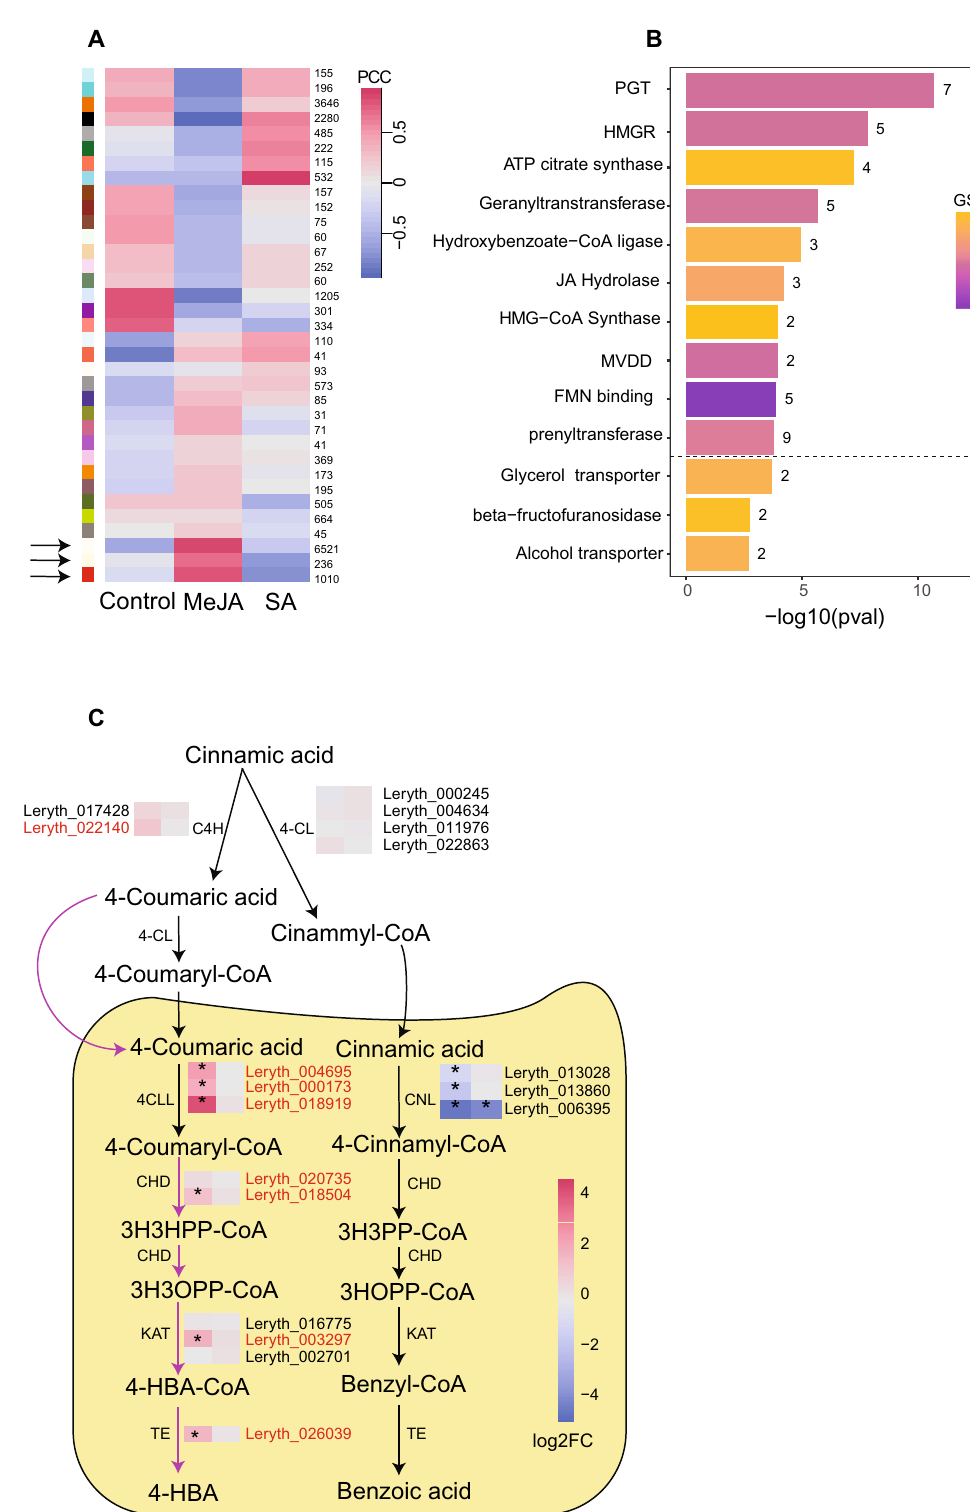
Figure 6. Weighted gene coexpression analysis in Lithospermum officinale . ( A ) Pearson correlation (PCC) of identified modules with each treatment. Each row of the heatmap depicts a single module of clustered genes with dark red and blue colours depicting strong positive and negative correlations, respectively. Numbers on the right represent the total number of genes coexpressed together in the respective module and each colour on the left represents an individual cluster of genes identified by WGCNA. ( B ) GO enrichment analysis of molecular functions of genes coexpressed with LePGT1 in the red subnetwork (n = 243) and LeSAT1 in the light-yellow module (n = 49) after filtering for gene significance (GS > 0.7) and module membership (> 0.7). The heatmap corresponds to the average GS of each GO category to the shikonin producing condition. Numbers on the right correspond to the number of genes in the respective GO term. ( C ) Expression levels of genes involved in the β-oxidative benzenoid pathway. Genes coexpressed together with LePGT1 in the red subnetwork are highlighted in